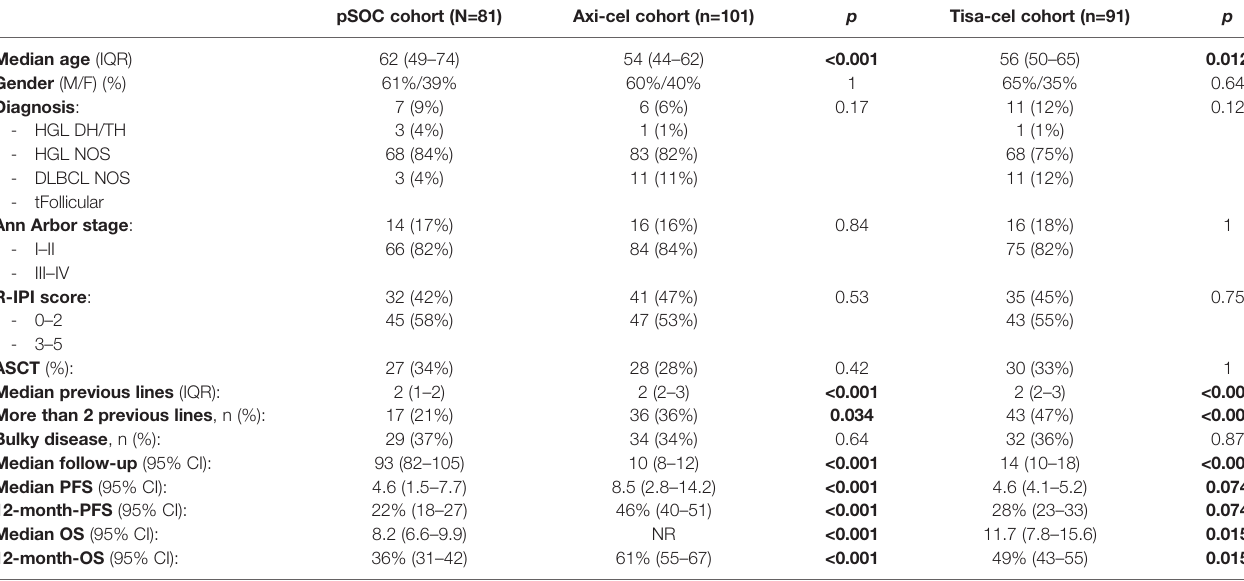
TABLE 2 | Comparison of the previous standard-of-care (pSOC) cohort and infused CAR-T cell, axi-cell, and tisa-cel cohorts. pSOC cohort (N=81)